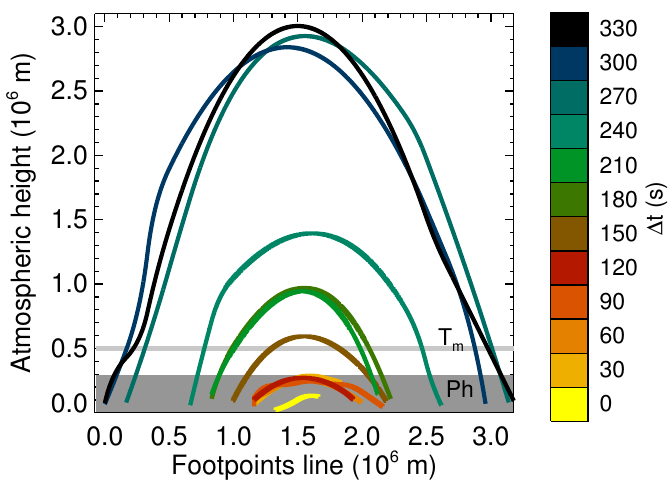
Figure 34: The passage of a magnetic loop from the photosphere to chromosphere as revealed by Hin- ode/SOT observations. Image reproduced with permission from Mart´ınez Gonz´alez et al. (2010), copyright by